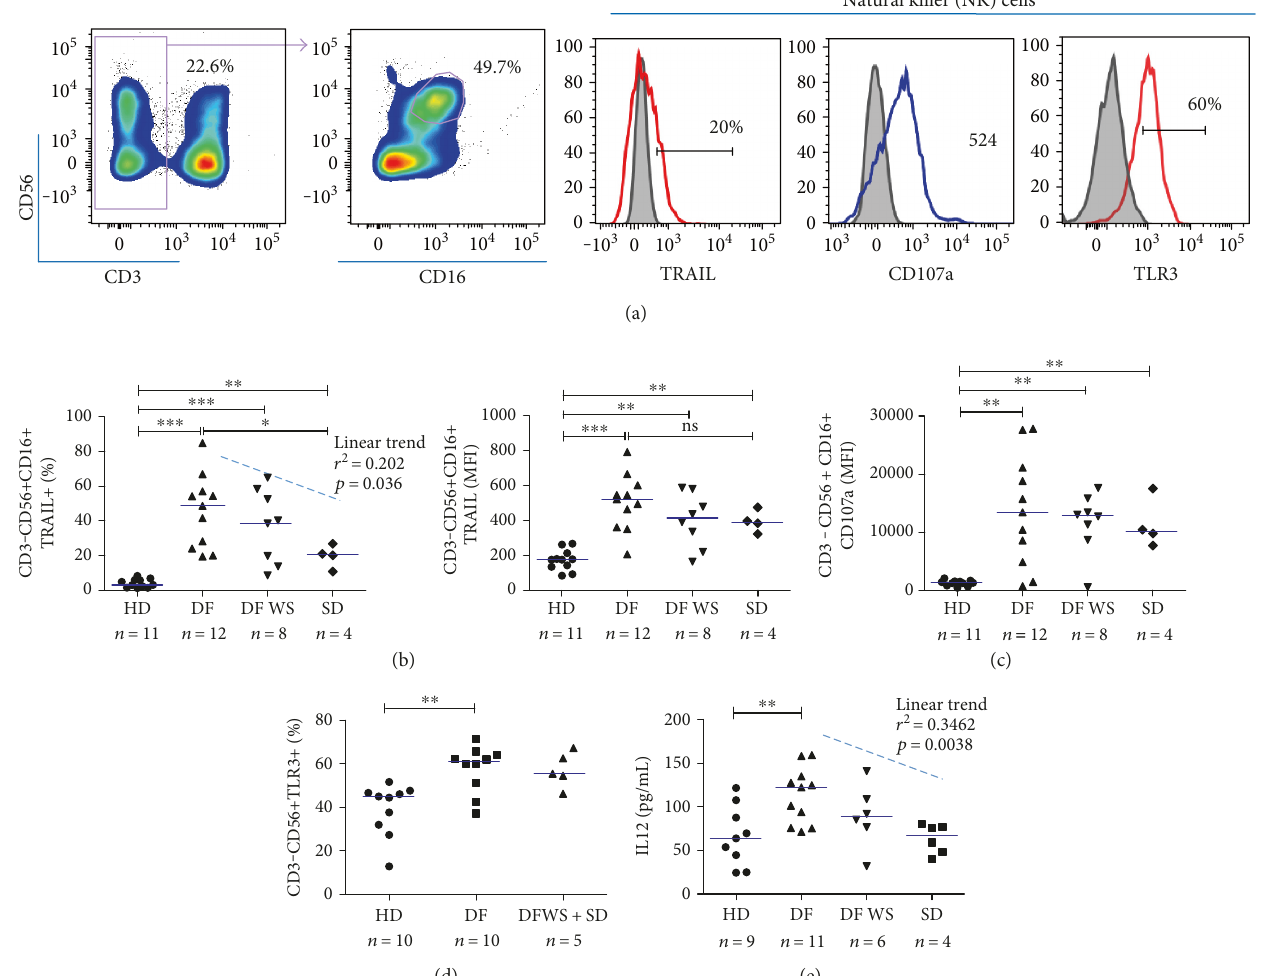
Figure 2: NK cell activation pro fi le in dengue-infected patients ’ samples. Patients ’ PBMCs collected during disease acute phase or healthy donors PBMCs were thawed and immediately phenotyped by CD3/CD56/CD16/TRAIL or TLR3/CD107a cell surface density analysis by fl ow cytometry. IL12 levels were detected in plasma samples by ELISA. Analyzed cells (a) were gated on CD3 − cells and then TRAIL- positive cells or TRAIL MFI (b) and CD107a median (c) were analyzed on CD3 − CD56+CD16+ NK cells. TLR3-positive cells (d) were detected in all CD56+ cells. IL12 levels (e) were detected at acute phase samples or healthy control samples. Subjects were grouped into healthy donors (HD) or patients with dengue fever without warning signs (DF), dengue fever with warning signs (DFWS), or severe dengue (SD). Values were submitted to Mann – Whitney statistical test (for comparison between two groups in which ∗ p < 0 05 , ∗∗ p < 0 005 and ∗∗∗ p < 0 0005 ) and one- way analysis of variance for linear tendency between group severity and analyzed